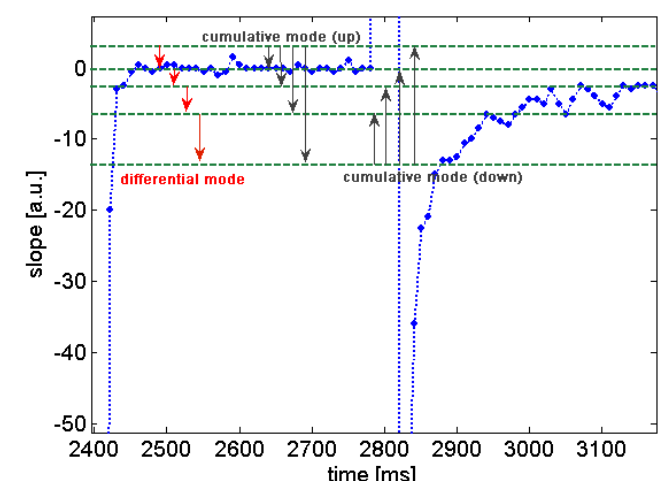
Figure 18. Multi-level thresholding used for extracting features of slope curves of gas sensors. MLT is modified from histogram and amplitude distribution computation by non-equal range of bins. Three methods of MLT are differential, cumulative (up) and cumulative (down)